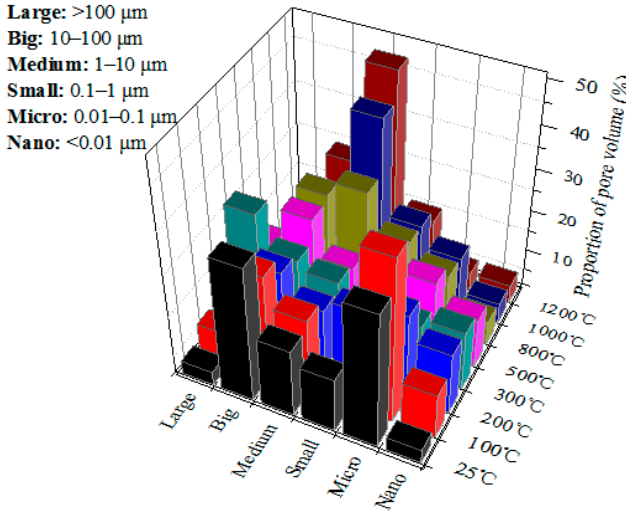
Figure 10. Volume proportion of the six types of pores in granite samples with increasing temperature.